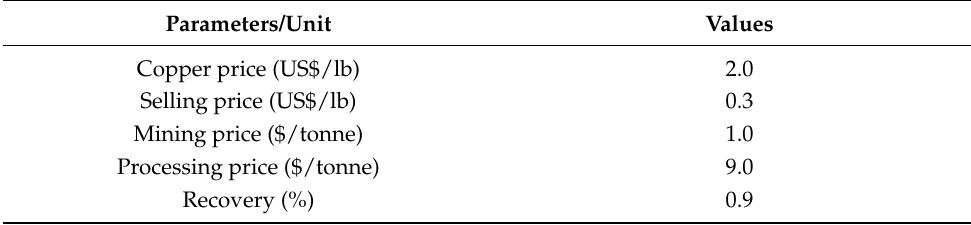
Table 1. Economic